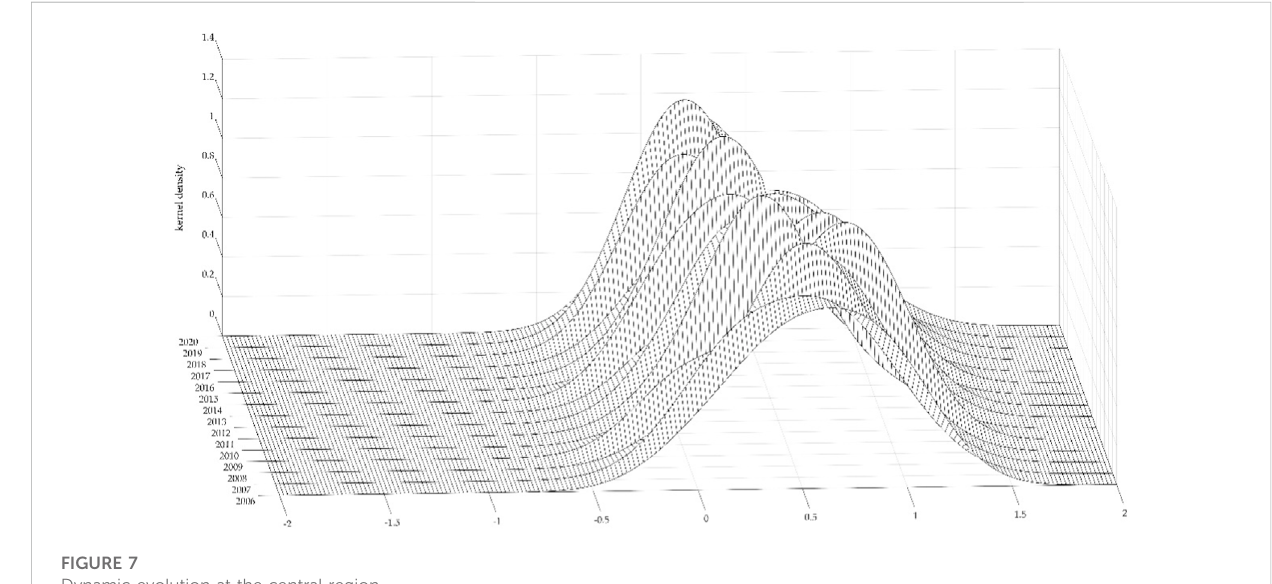
FIGURE 7 Dynamic evolution at the central region.